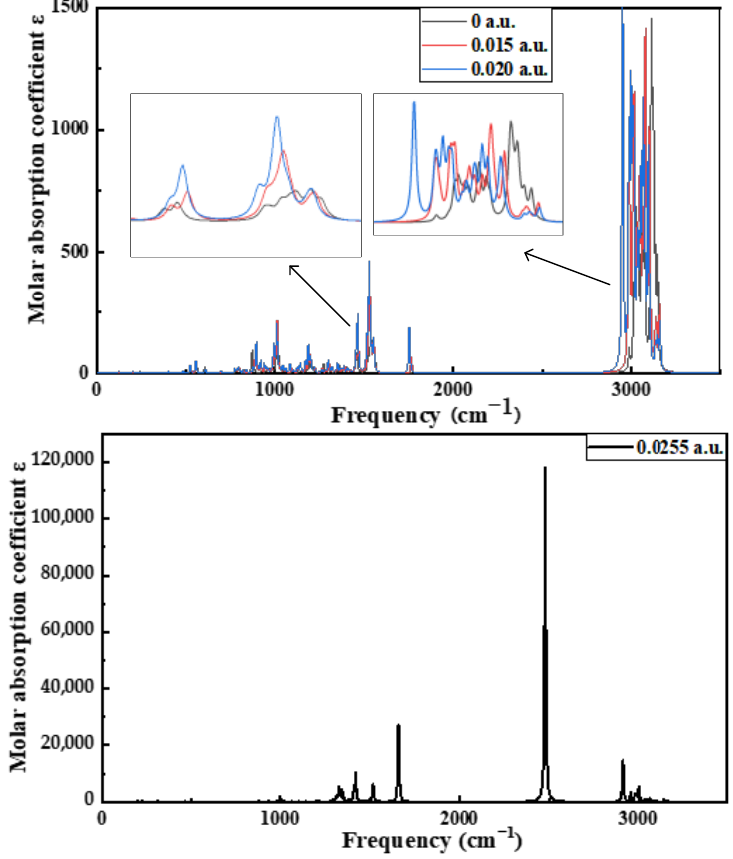
Figure 10. Infrared spectra of ENB-EPDM molecules with different electric field intensities.